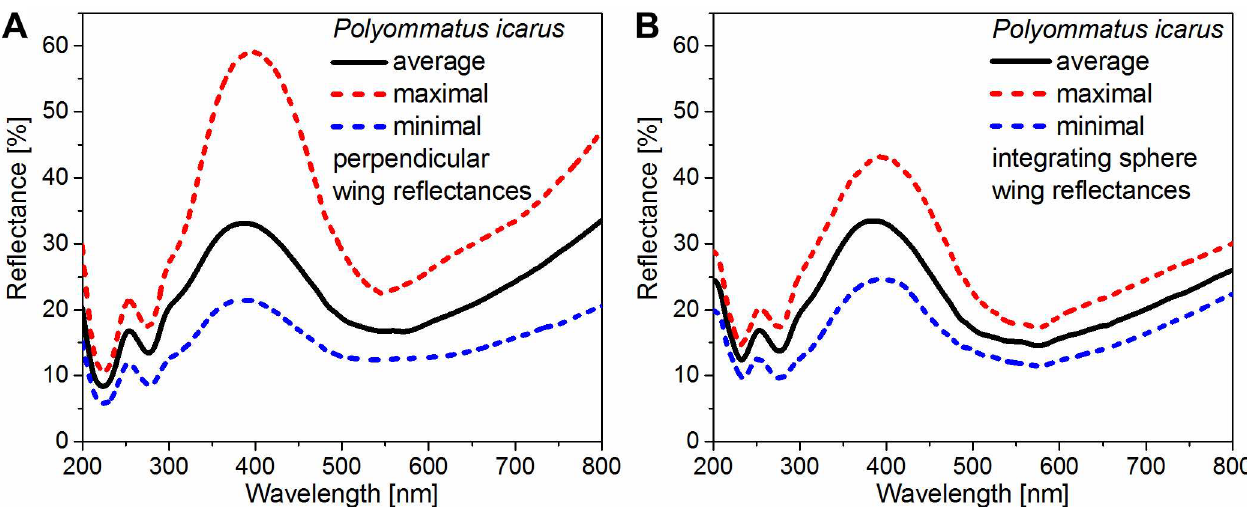
Fig 5. Averaged reflectance spectraof Polyommatus icarus measuredusing the two optical setups. The results of the (A) perpendicular and (B) integratingspherelight-collecting setups are shown. The red and blue curves show the recordedmaximal and minimal wing reflectance (n = 100 each), respectively.The averageof all measurements (drawn in black) is shown betweenthe red and blue curves.